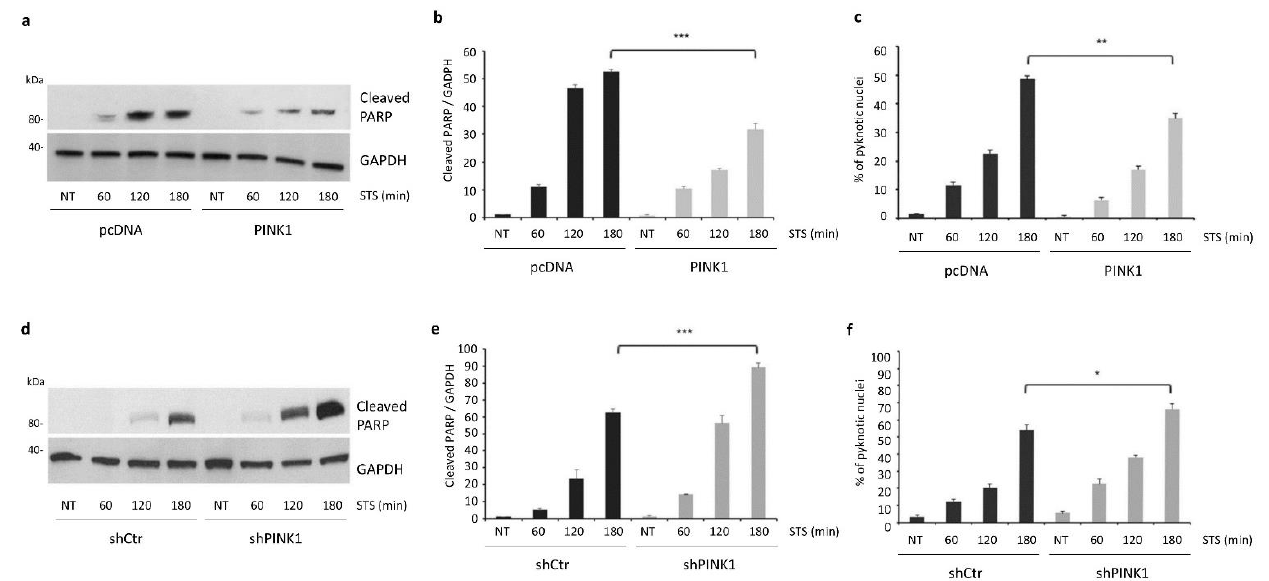
Figure 4. PINK1 protects from STS-induced cell death. ( a ) Immunoblot analysis of PARP cleavage in SH-SY5Y cells overexpressing PINK1 or vector alone (pcDNA) and then treated either with STS (for 1, 2 and 3 h) or with DMSO for 3 h (NT). For PINK1 expression in the same experimental